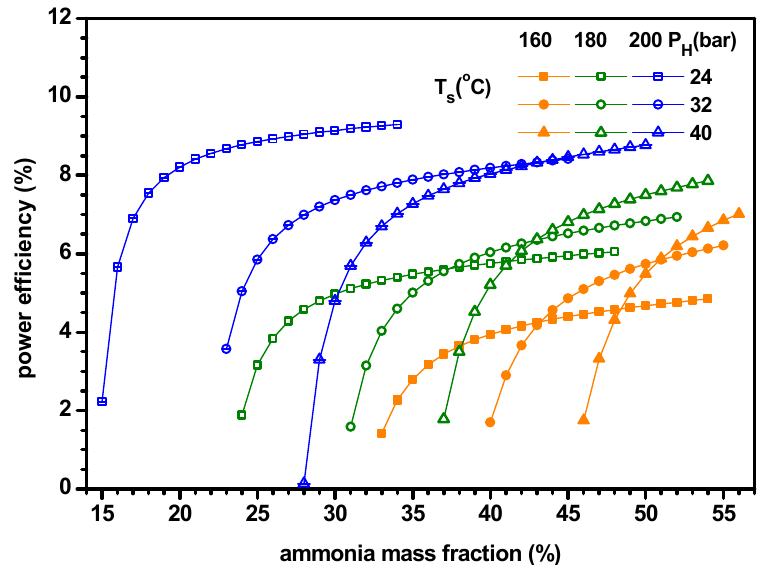
Figure 12. Power efficiency for varying ammonia fraction. Figure 12. Power e ffi ciency for varying ammonia fraction.